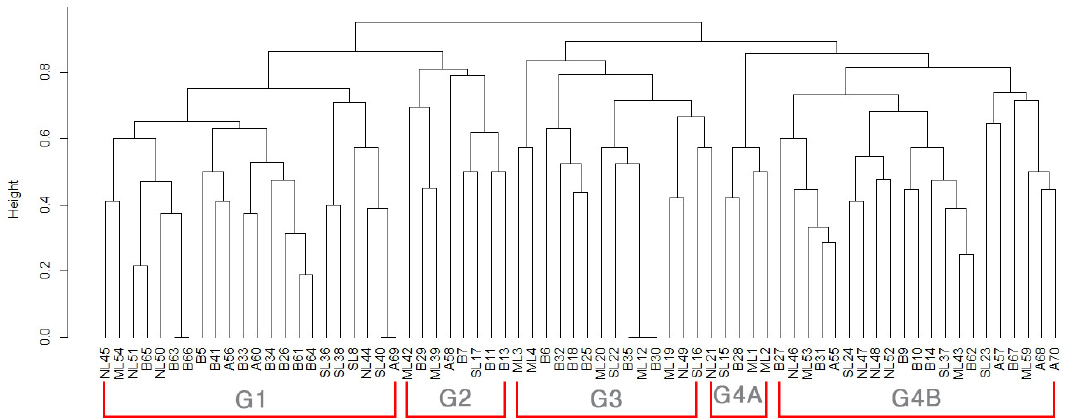
Figure 5. Cluster analysis of 70 snake melon accessions by unweighted pair-group method with arithmetic mean (UPGMA) using Jaccard’s similarity coefficient.